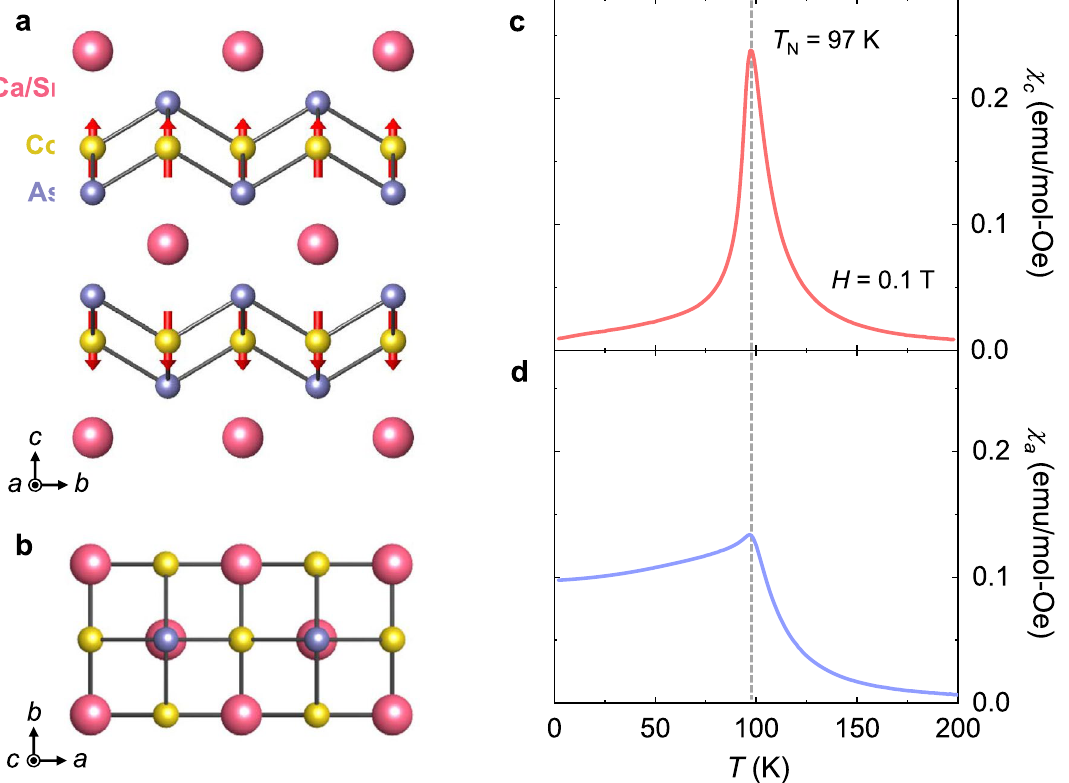
Figure 1. Structure and magnetic susceptibility of antiferromagnetic Ca 0.9 Sr 0.1 Co 2 As 2 (CSCA). ( a ) Crystallographic structure of body-centered tetragonal CSCA viewed from the a -axis. The pink, yellow, and purple spheres represent Ca/Sr, Co, and As atoms, respectively. The red arrow on the Co atom indicates the individual spin direction. The right red arrow indicates the net magnetic moment of each Co 2 As 2 layer. ( b ) Structure of the CSCA viewed from the c -axis. ( c ) Magnetic susceptibility for H//c ( χ c ) as a function of the temperature ( T ), taken upon warming at H = 0.1 T after zero-field cooling. ( d ) Magnetic susceptibility for H//a ( χ a ) as a function of T at H = 0.1 T. The vertical line denotes the onset of antiferromagnetic (AFM) order, T N = 97